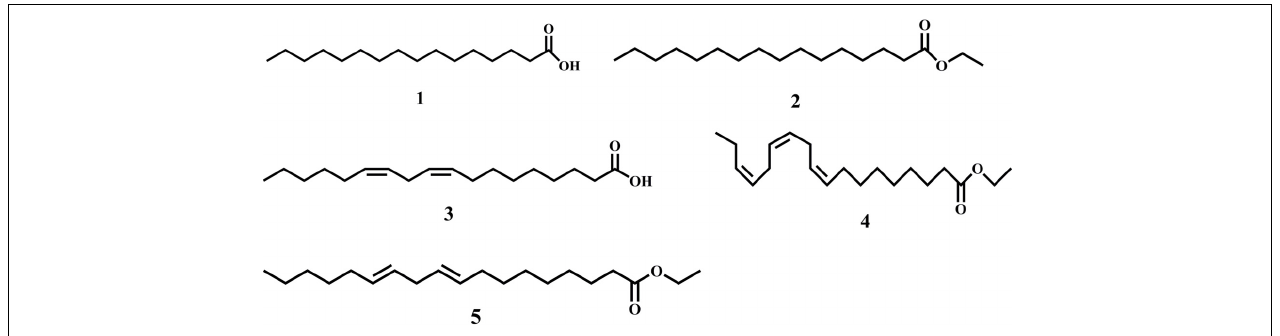
FIGURE 2 | Structures of five major components found in sweet potato petroleum ether extract: (1) palmitic acid; (2) ethyl palmitate; (3) linoleic acid; (4) ethyl linolenate; (5) ethyl linoleate. The numbers of individually tested components are underlined. TABLE 2 | Effects of five components of sweet potato ether petroleum extract on the growth of Lolium multiflorum and Phalaris minor . Compound Concentration/ (mg mL − 1 )